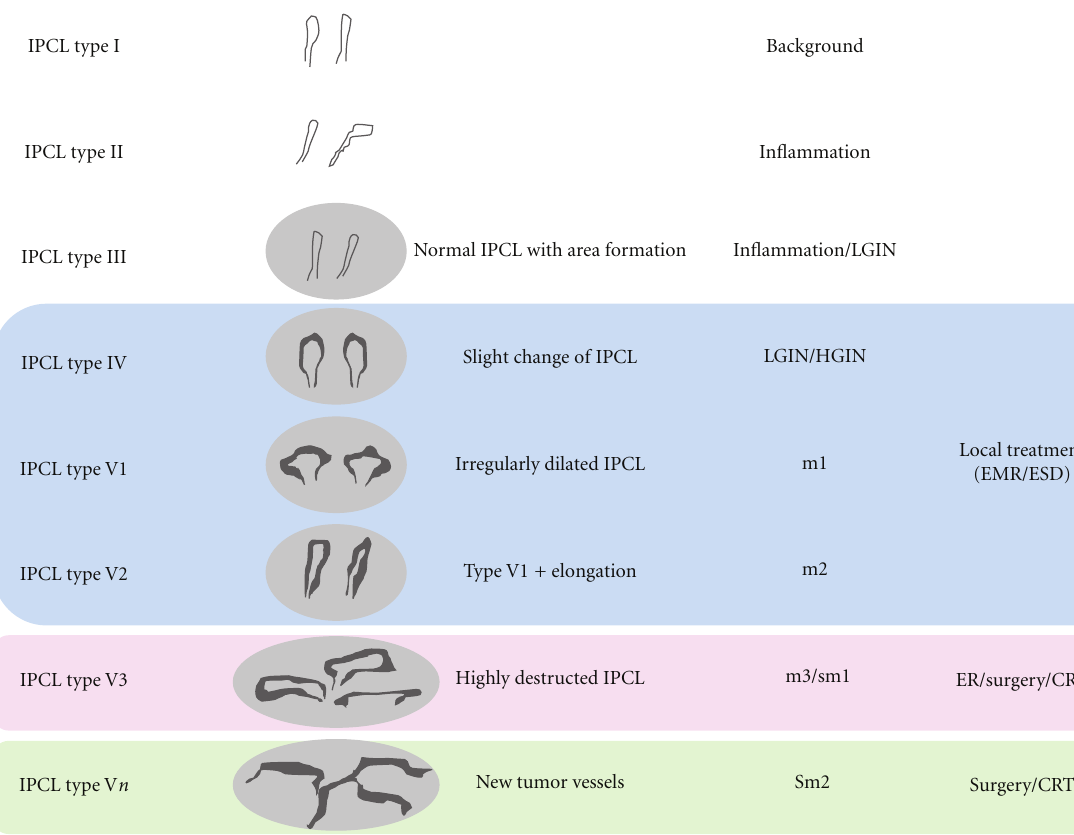
Figure 1: IPCL pattern classification, which was introduced by Inoue et al. in 2001. Most of IPCL type I to III is corresponding to benign pathology including inflammation and low grade neoplasia (LGN). Approximately 50% of IPCL type IV is corresponding to LGN, and the rest is corresponding to malignant pathology including high grade neoplasia (HGN). IPCL type V is a malignant pattern and subclassified into 4 categories. V1 and V2 could be removed by endoscopic resection (ER) such as EMR and ESD. IPCL type V3 includes m3 and sm1 cancers. IPCL type Vn is a pattern for massively submucosally invasive cancers. ∗ CRT: